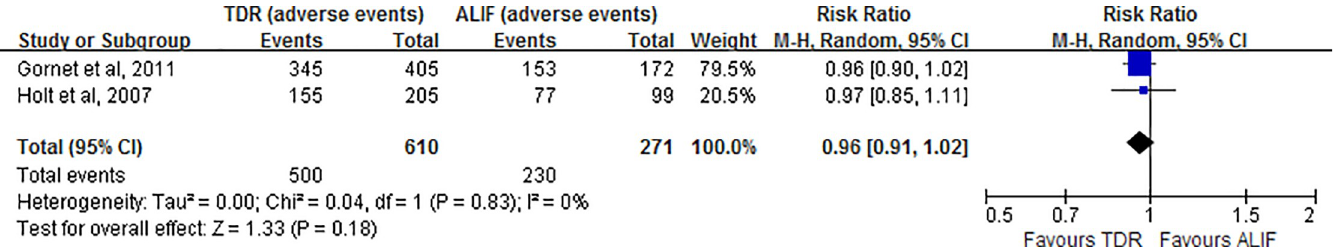
PLOS ONE | https://doi.org/10.1371/journal.pone.0209660 December28,